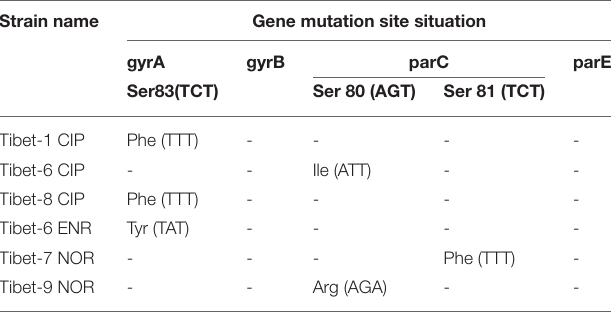
TABLE 4 | The QRDR mutations of clinical drug-resistant